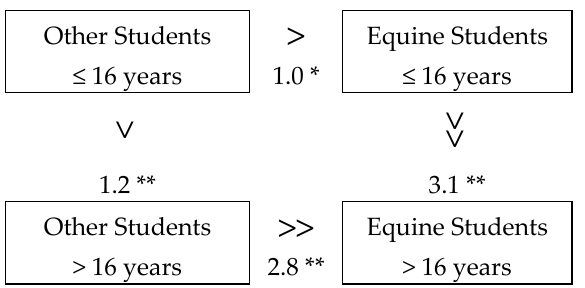
Table 4. Results of the multiple linear regression model.